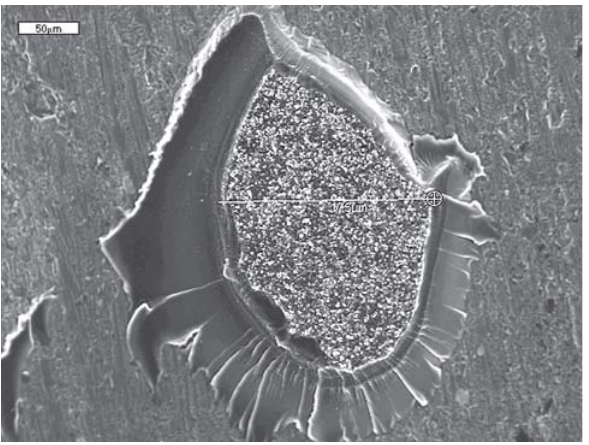
FIGURE 8- SEM micrograph of a fractured surface with an internal flaw as the crack origin (c); the measurement of the flaw minor axis is 2b = 175 µm (x250). From Della Bona, et al . 18 , 2003